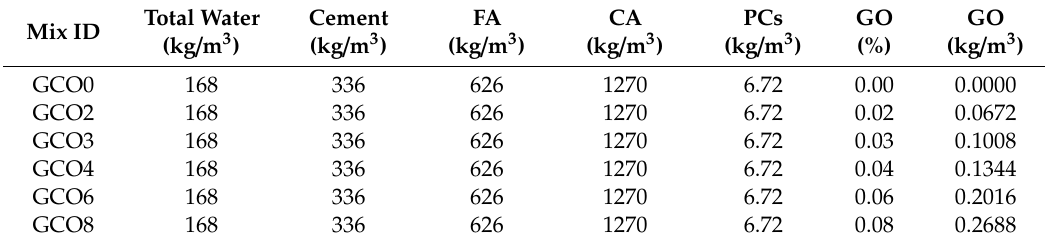
Table 3. Concrete mixture proportions.